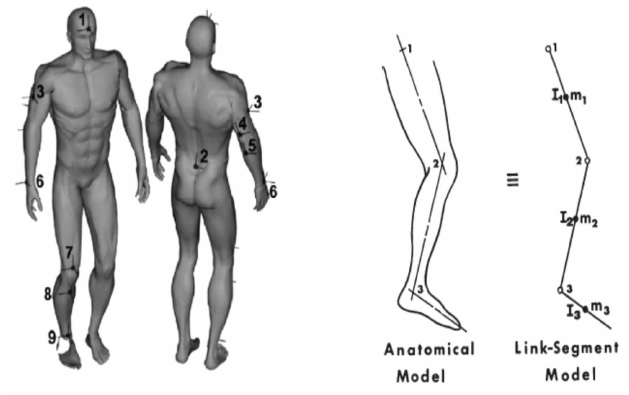
Figure 1: Major body locations for analyzing human movement [12,